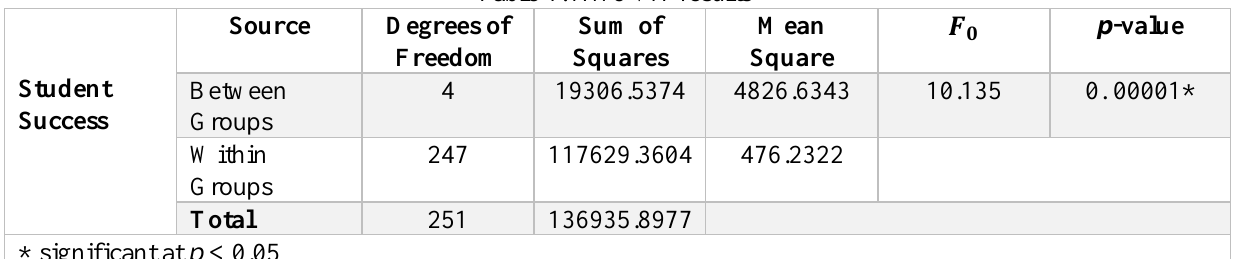
Table 1. ANOVA results